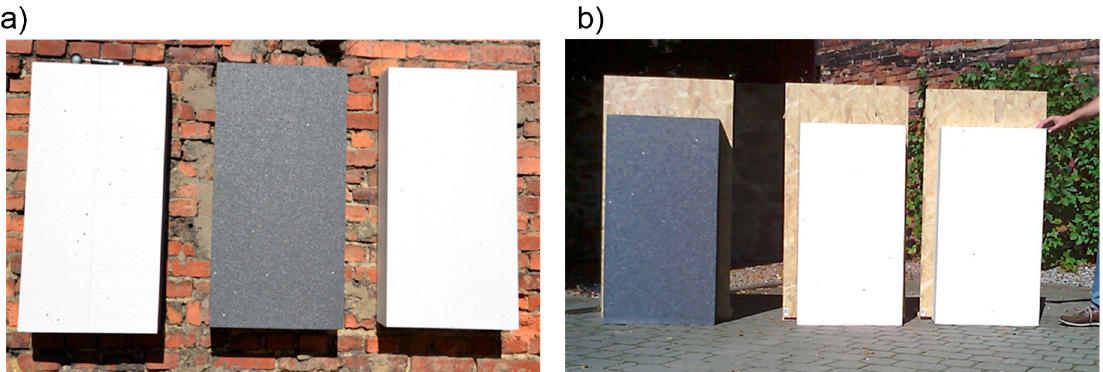
Figure 2. Stand for the in situ tests. ( a ) stationary stand, ( b ) mobile stand.